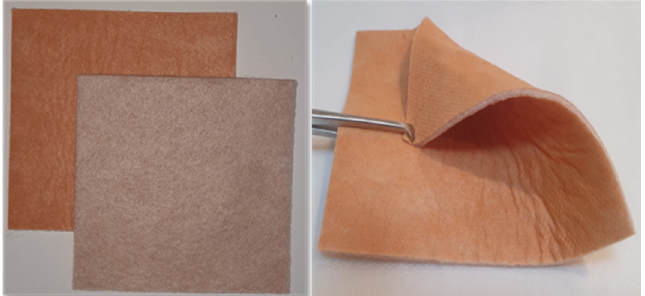
Figure 1. The studied copper oxide dressings. The antibacterial wound dressings with copper oxide (COD) are sterile wound dressings composed of an internal absorbent layer and one (left panel) or two (right panel) external nonwoven layers, with or without an adhesive contour. The external layer(s) are made of polypropylene nonwoven fabric, and the internal layer is made of a needle punch layer made of polyester and hydrofibers. The wound dressings achieve at least 800% weight/weight fluid absorbency. Both the internal and external layers are impregnated with copper oxide microparticles. The one or two external layers cover the internal layer from one or both sides, accordingly, and are applied directly to the wound.